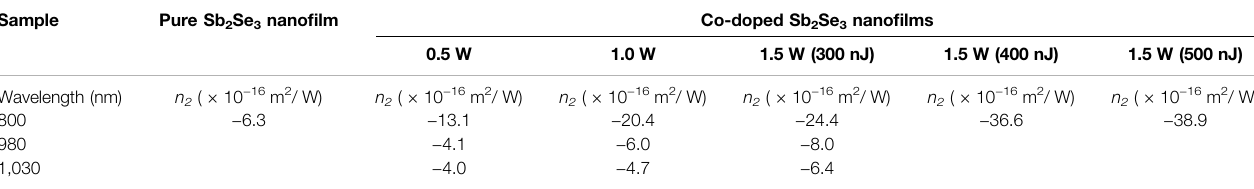
TABLE 2 | Nonlinear refractive index of pure and Co-doped Sb 2 Se 3 nano fi lms under different excitation conditions.